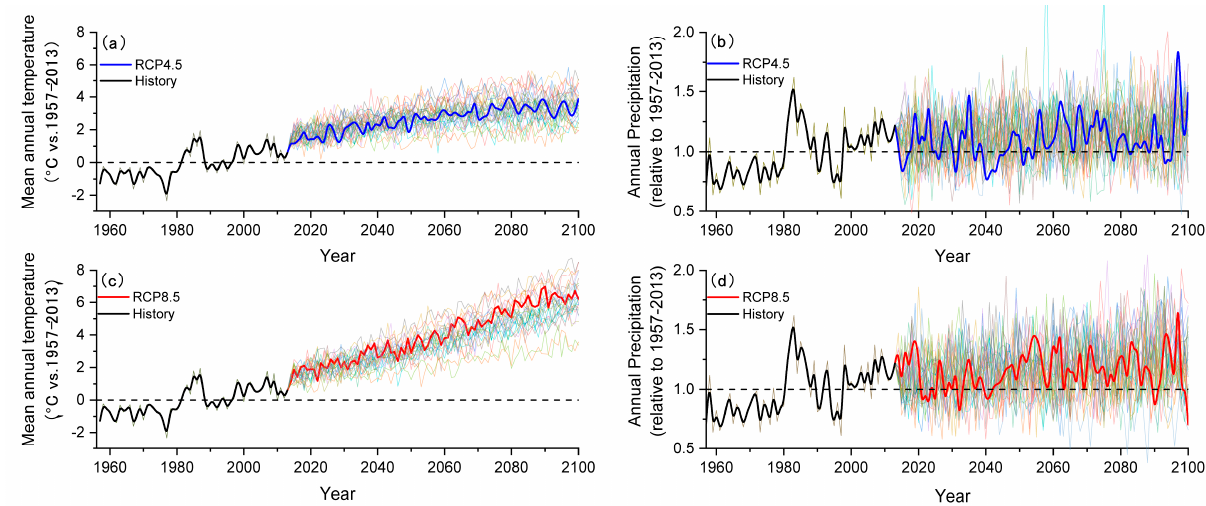
Figure 3. De-biased temperature anomaly ( a , c ) and de-biased precipitation anomaly ( b , d ) between 1957 and 2100 relative to 1957–2013 (horizontal dotted line). The thick black line represents the variables’ progress across the observation period. The colored thin lines reflect the evolution of each GCM simulation in the CMIP5 ensemble (31 in total; see Table 1). The thick red and blue lines are the means of GCM simulations. Table 2. List of the global climate models in CMIP5 used in this research.